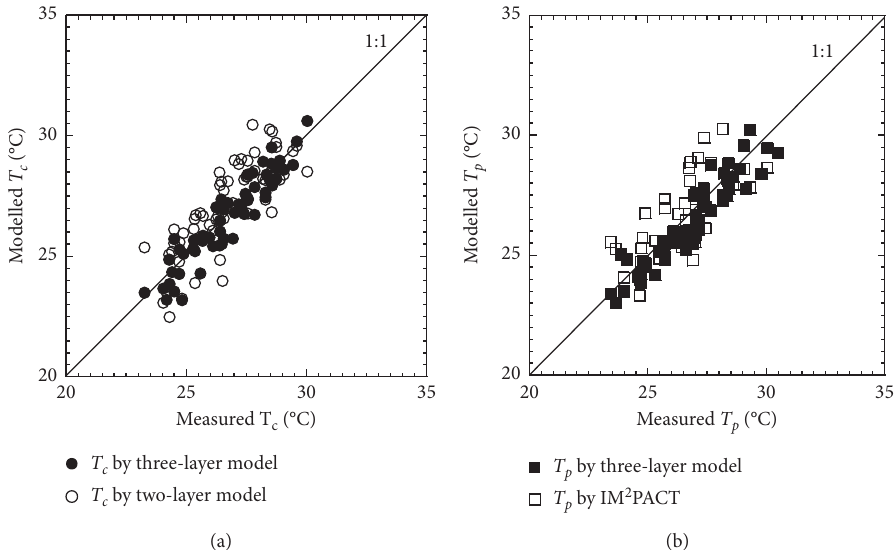
Figure 7: Comparison of T c by the three-layer model and the two-layer model (a) and T p by the three-layer model and IM rice paddy field from August 5 to September 7, 2014.